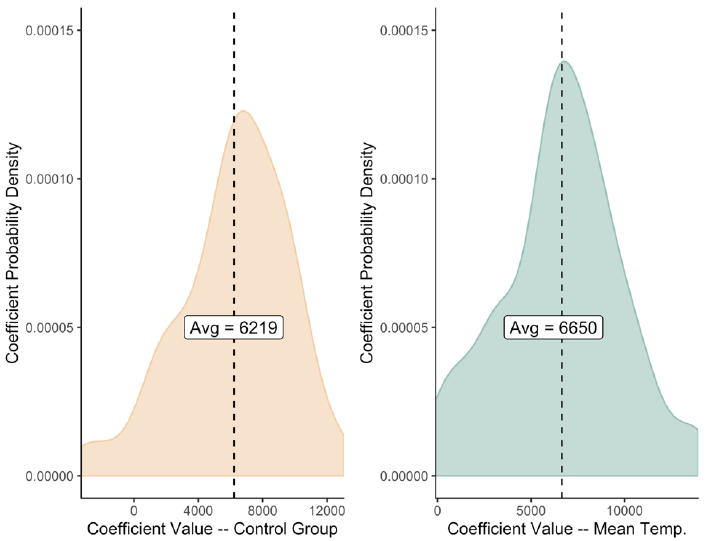
Figure 7. The coefficient values for the two included covariates in the BSTS model built to produce the counterfactual used for M&V of the demand response